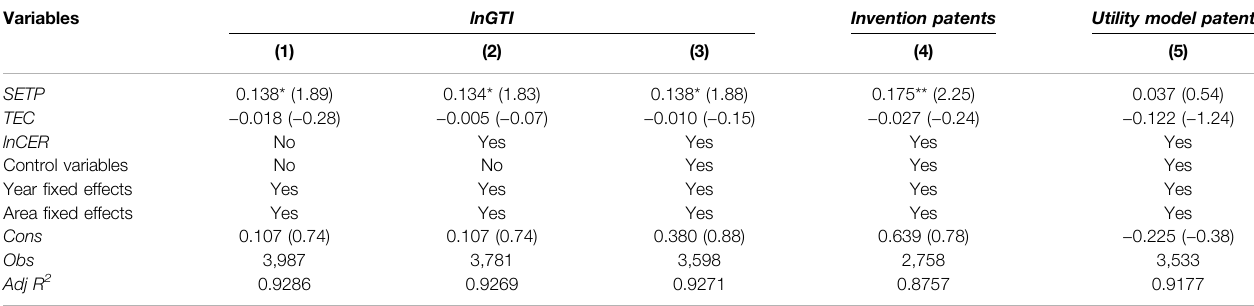
TABLE 9 | Estimation results of policy uniqueness test. Variables